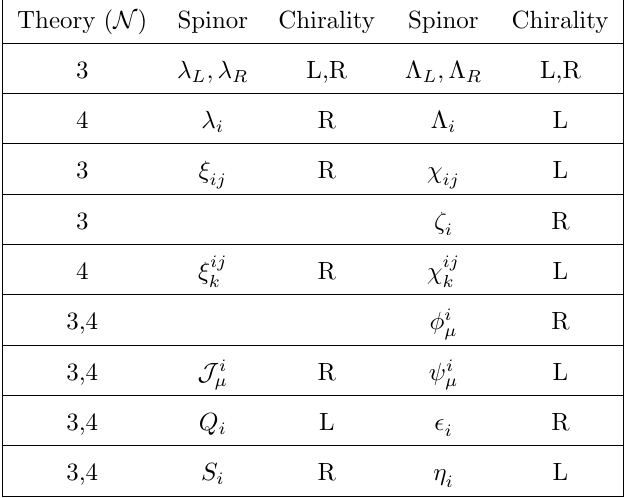
Table 6 . The handedness of the di(cid:11)erent spinors with respect to the chiral